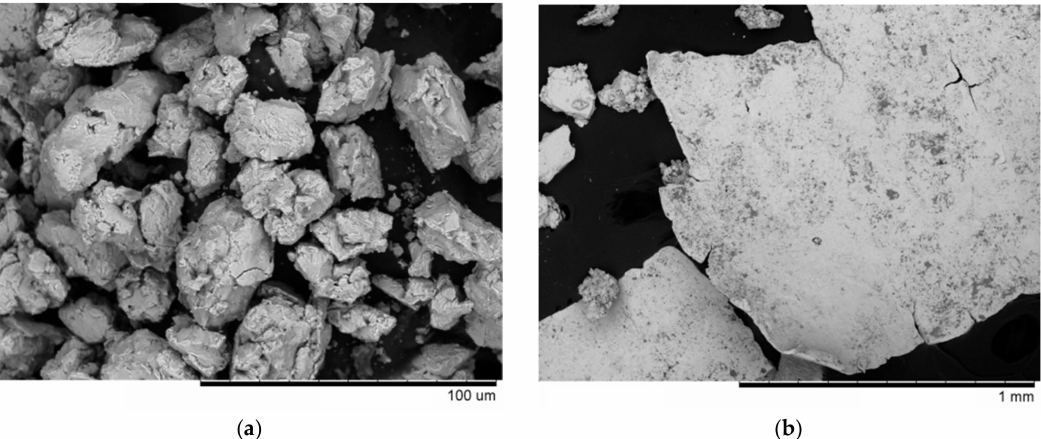
Figure 2. Morphology of the powder agglomerates obtained by ball milling of Ti 25 Cu 75 alloy ribbons with nanodiamonds ( a ); pieces of ribbons remaining in the product of ball milling ( b